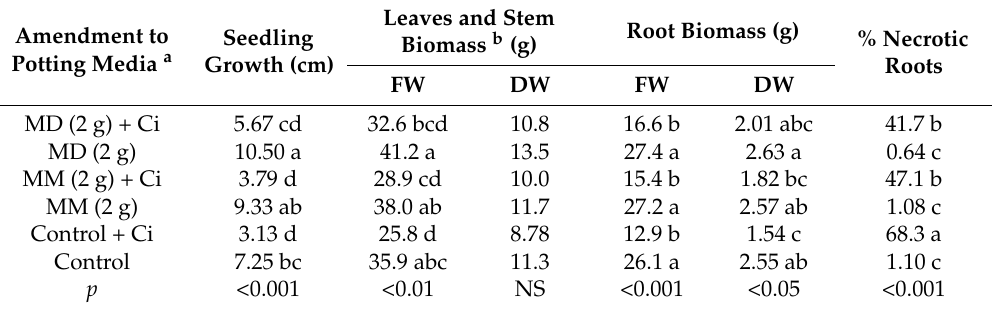
Mean values followed by the same letter are not significantly different at the p values indicated ( n = 12). a Two separate doses of MD/MM were applied. First application was 30 days before Ci inoculation and